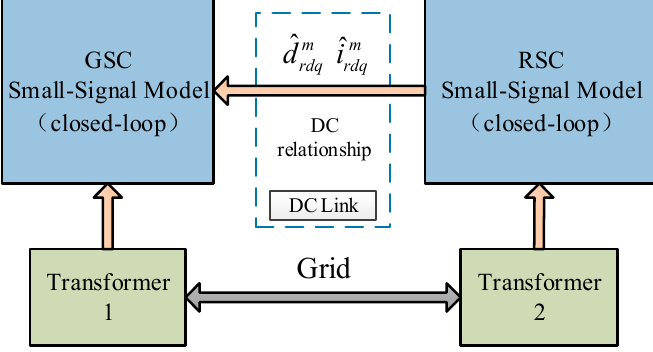
Figure 14. The schematic diagram of RSC and GSC in DFIG. The RSC and GSC small-signal models are interconnected with their dc variables in a dc link, and these two kinds of converters are all connected with the power grid through transformers. The system is thus a closed-loop system.